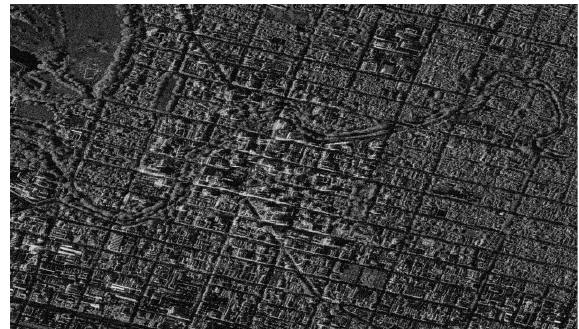
Figure 1 . TerraSAR-X image of Christchurch, New